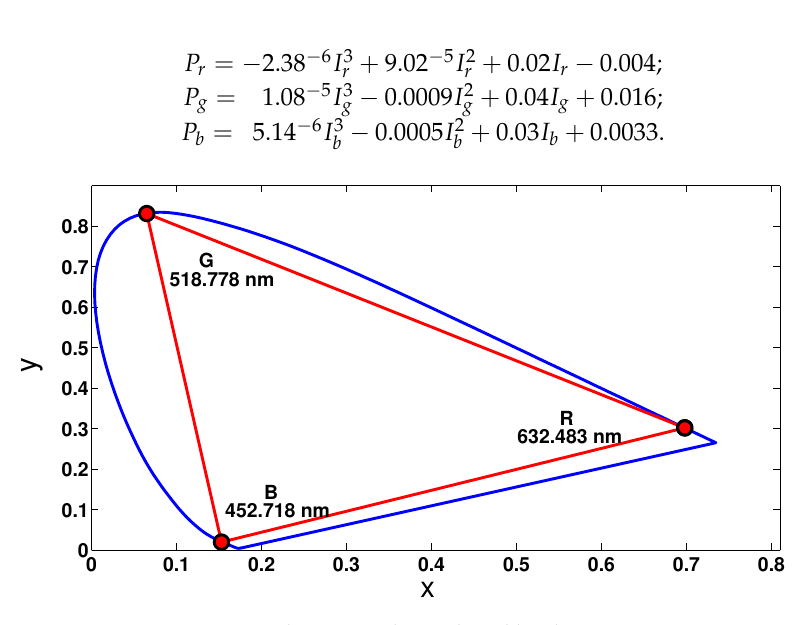
Figure 4. Colour triangle produced by the RGB LED.